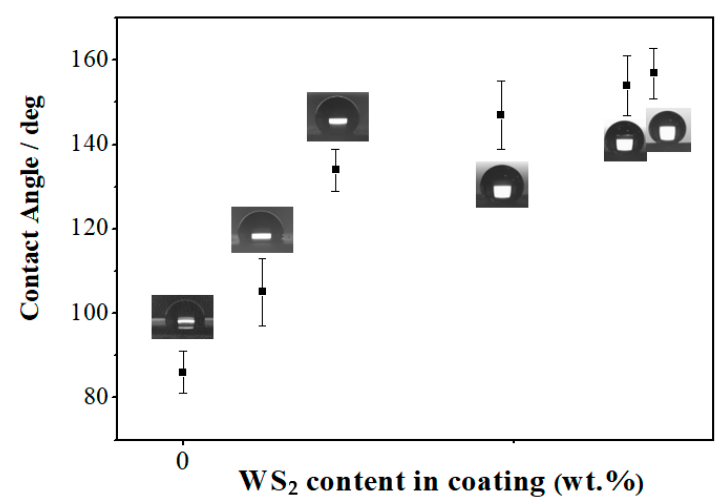
Figure 10. The variation in contact angle of water on the electrodeposited Ni–Co/WS 2 coatings against the concentrations of WS 2 in solution.